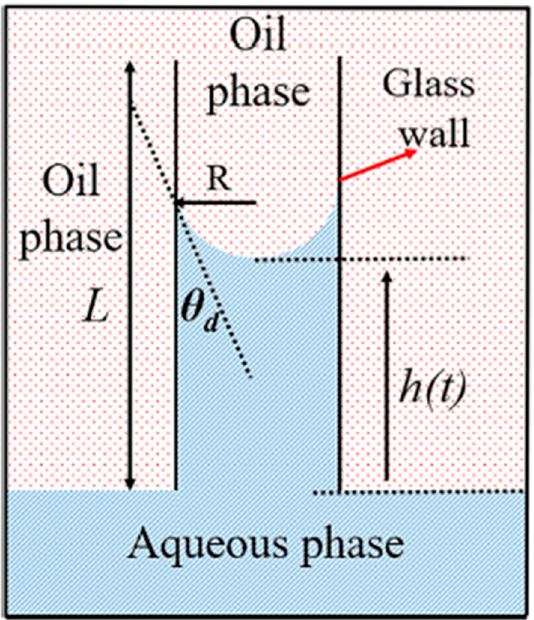
Figure 14. Experimental setup for the aqueous phase displacing the oil phase in the capillaries. Reprinted with permission from [53]. Copyright 2018 Elsevier.